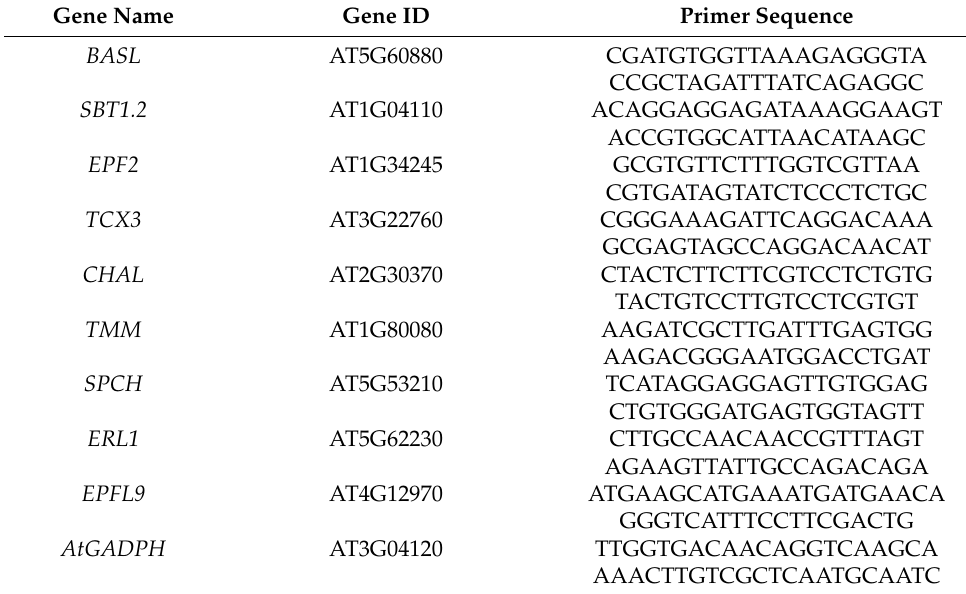
Table 3. Primers used for qRT-PCR analysis.